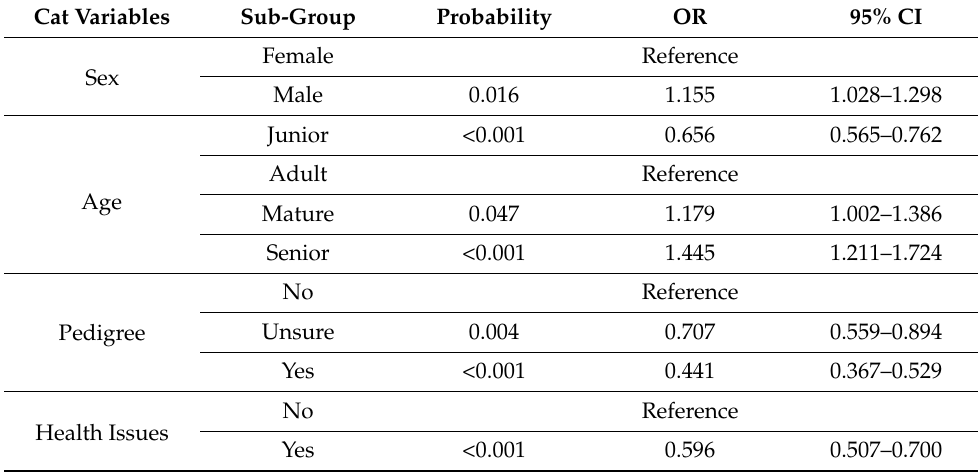
Table 4. Model 2, cat demographics: Results of 4909 cat variables tested through binary logistic regression for their association with cat lifestyle. Cat features that increase their odds of being provided outdoor access are indicated by an OR greater than one, whilst an OR lower than one indicates cat features that increase odds of being kept as indoor-only.